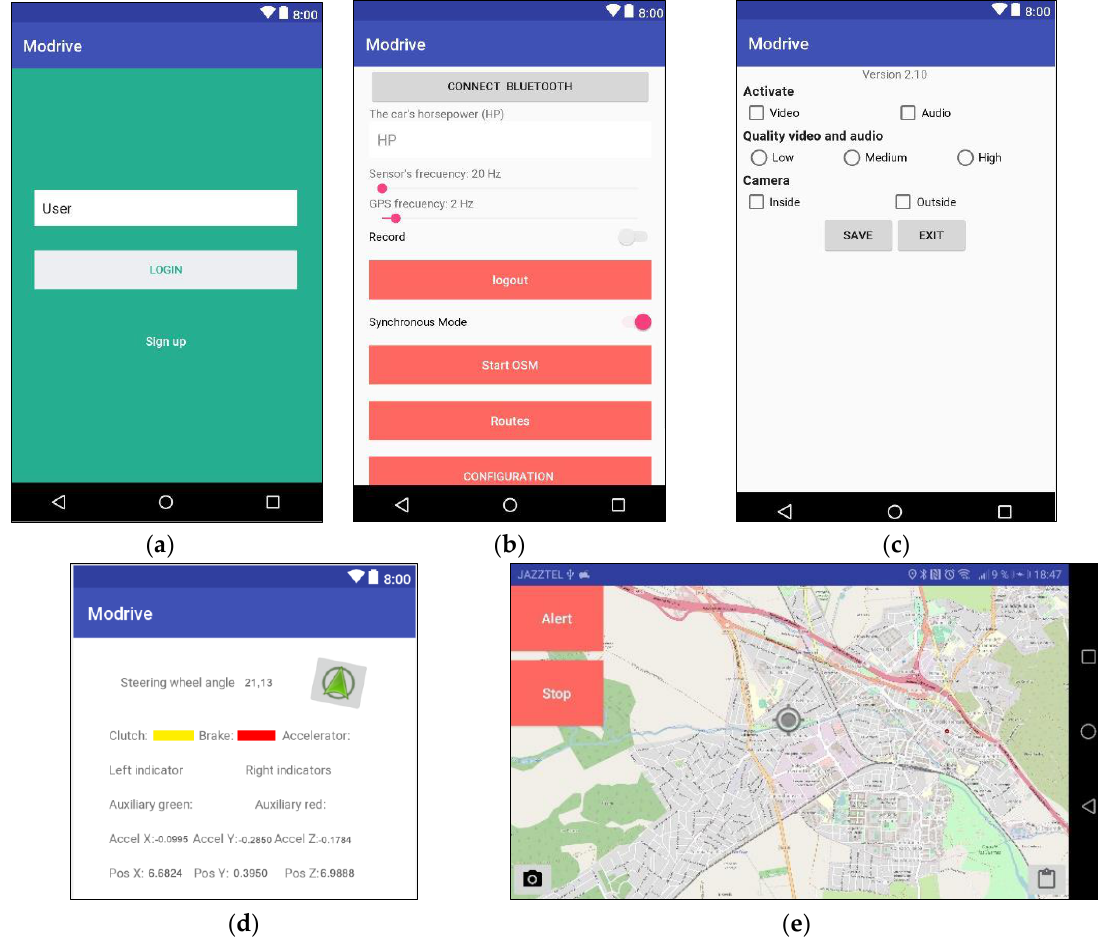
Figure 6. Data collection APP screens: ( a ) user ID; ( b ) basic route data and options menu; ( c ) video and audio settings; ( d ) view of vehicle status in the application. Specifically, this includes the information regarding data captured by the Arduino board (steering wheel rotation, pedal status, intermittent, and auxiliary buttons) as well as data from the Smartphone’s accelerometer. ( e ) View of data capture in route.